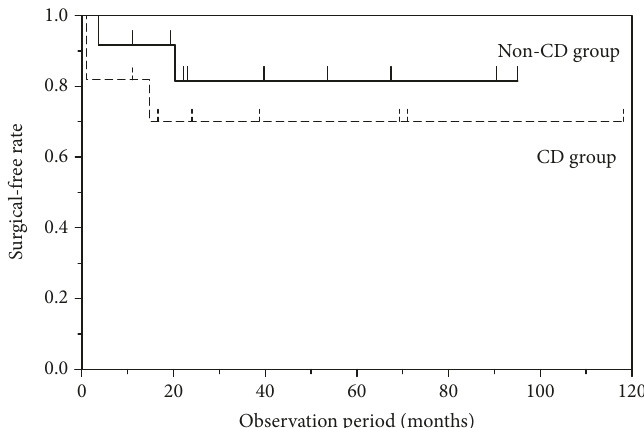
Figure 3: The cumulative surgery-free rate. The cumulative surgery-free rate of EBD cases after 1 year and 2 years from the initial EBD in the non-CD and CD groups was 92% (11/12) and 83% (10/12) and 82% (9/11) and 73% (8/11), respectively. There were no signi fi cant di ff erences in the surgical-free rate between the non-CD and CD groups. Table 5: Outcomes of endoscopic balloon dilation between the non-Crohn ’ s disease (CD) group and CD groups.